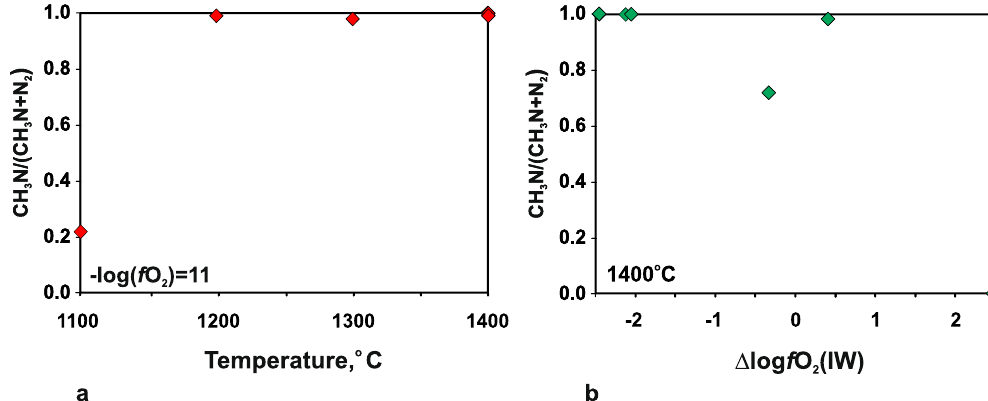
Figure 9. Normalised peak area ratios of CH 3 N and N 2 that characterise their role as nitrogen species in C-O- H-N fluids in a large range of T - f O 2 parameters at 6.3 GPa. ( a ) 1100–1400 °C and constant f O 2 ; ( b ) redox interval from strongly to moderately reduced conditions.